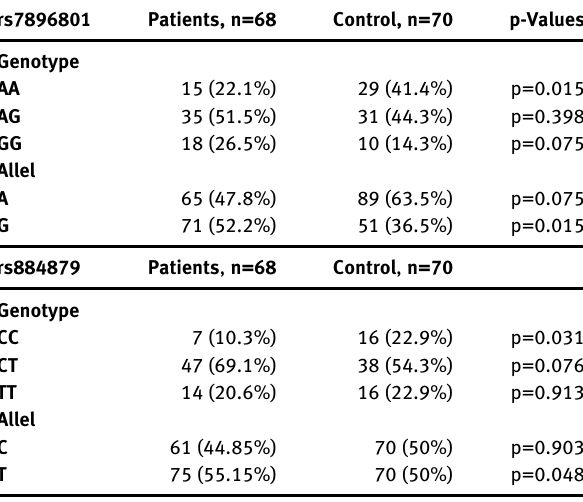
Table  : DistributionofRASSF  rs  andrs  genotype and alleles in study groups.